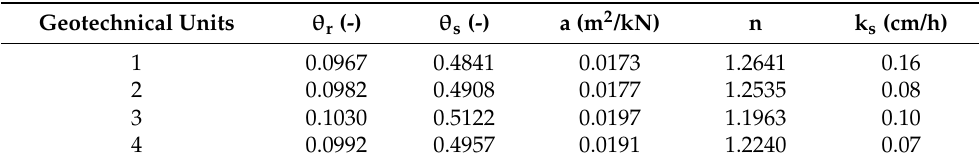
Table 2. Retention curve’s parameters of the soil covers in relation to the geotechnical unit cropping out, according to the ROSETTA Lite